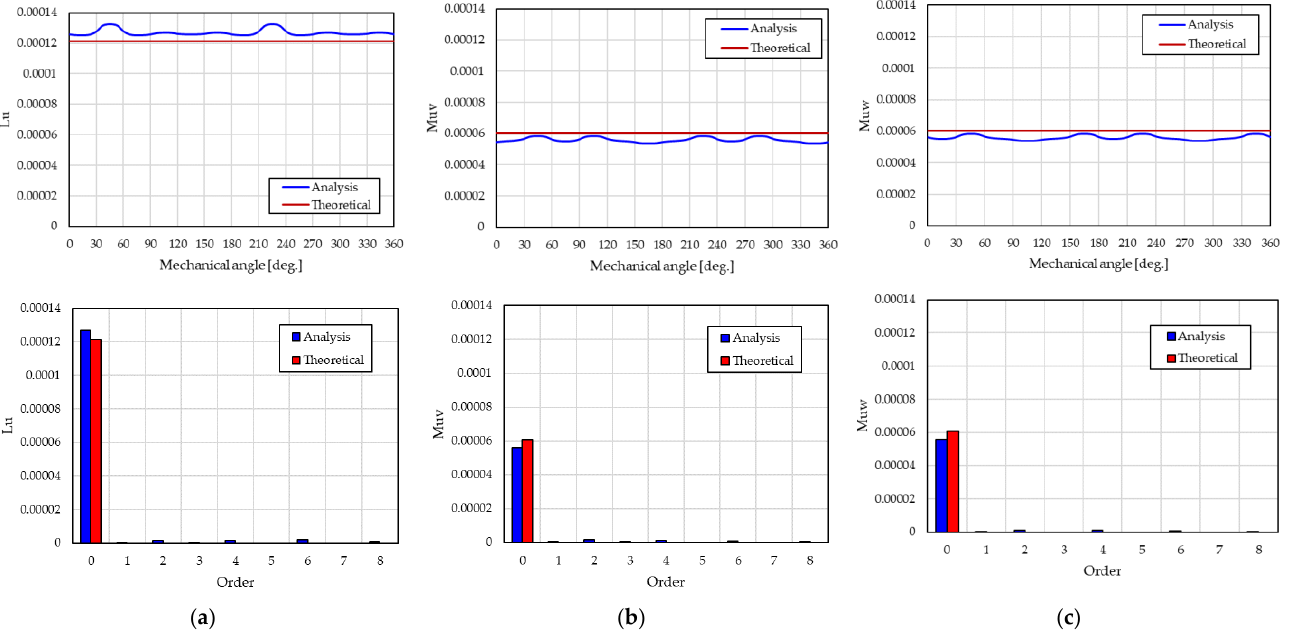
Figure 14. Comparison of inductance between analytical and theoretical value in U-phase: ( a ) L u ; ( b ) M uv ; ( c ) M uw .